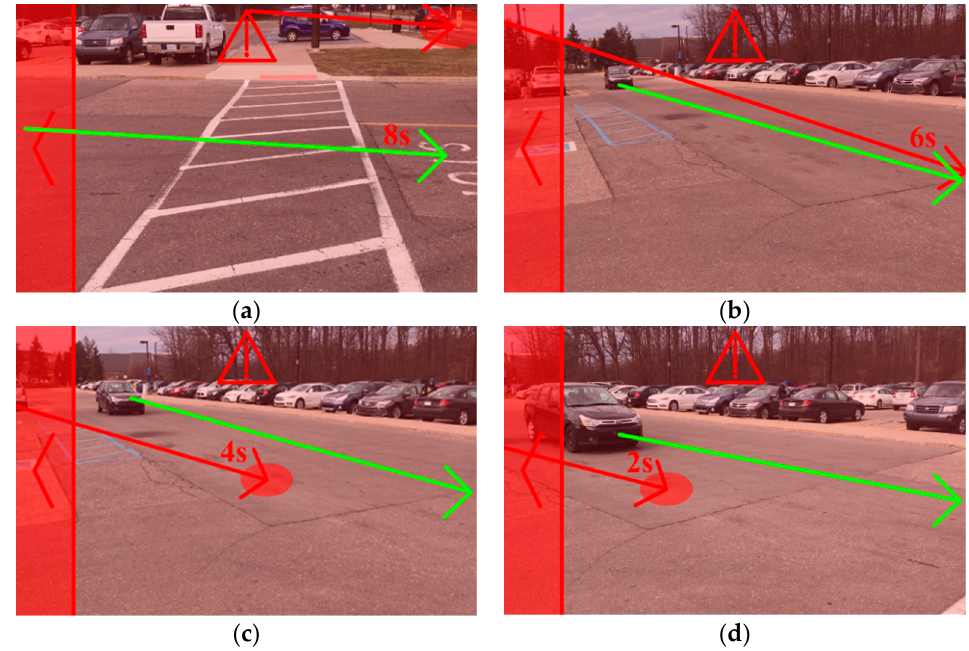
Figure 11. Projected video path (red) and ideal vehicle path (green) in the video image. ( a ) Vehicle path at 1 s; ( b ) vehicle path at 3 s; ( c ) vehicle path at 5 s; ( d ) vehicle path at 7 s.